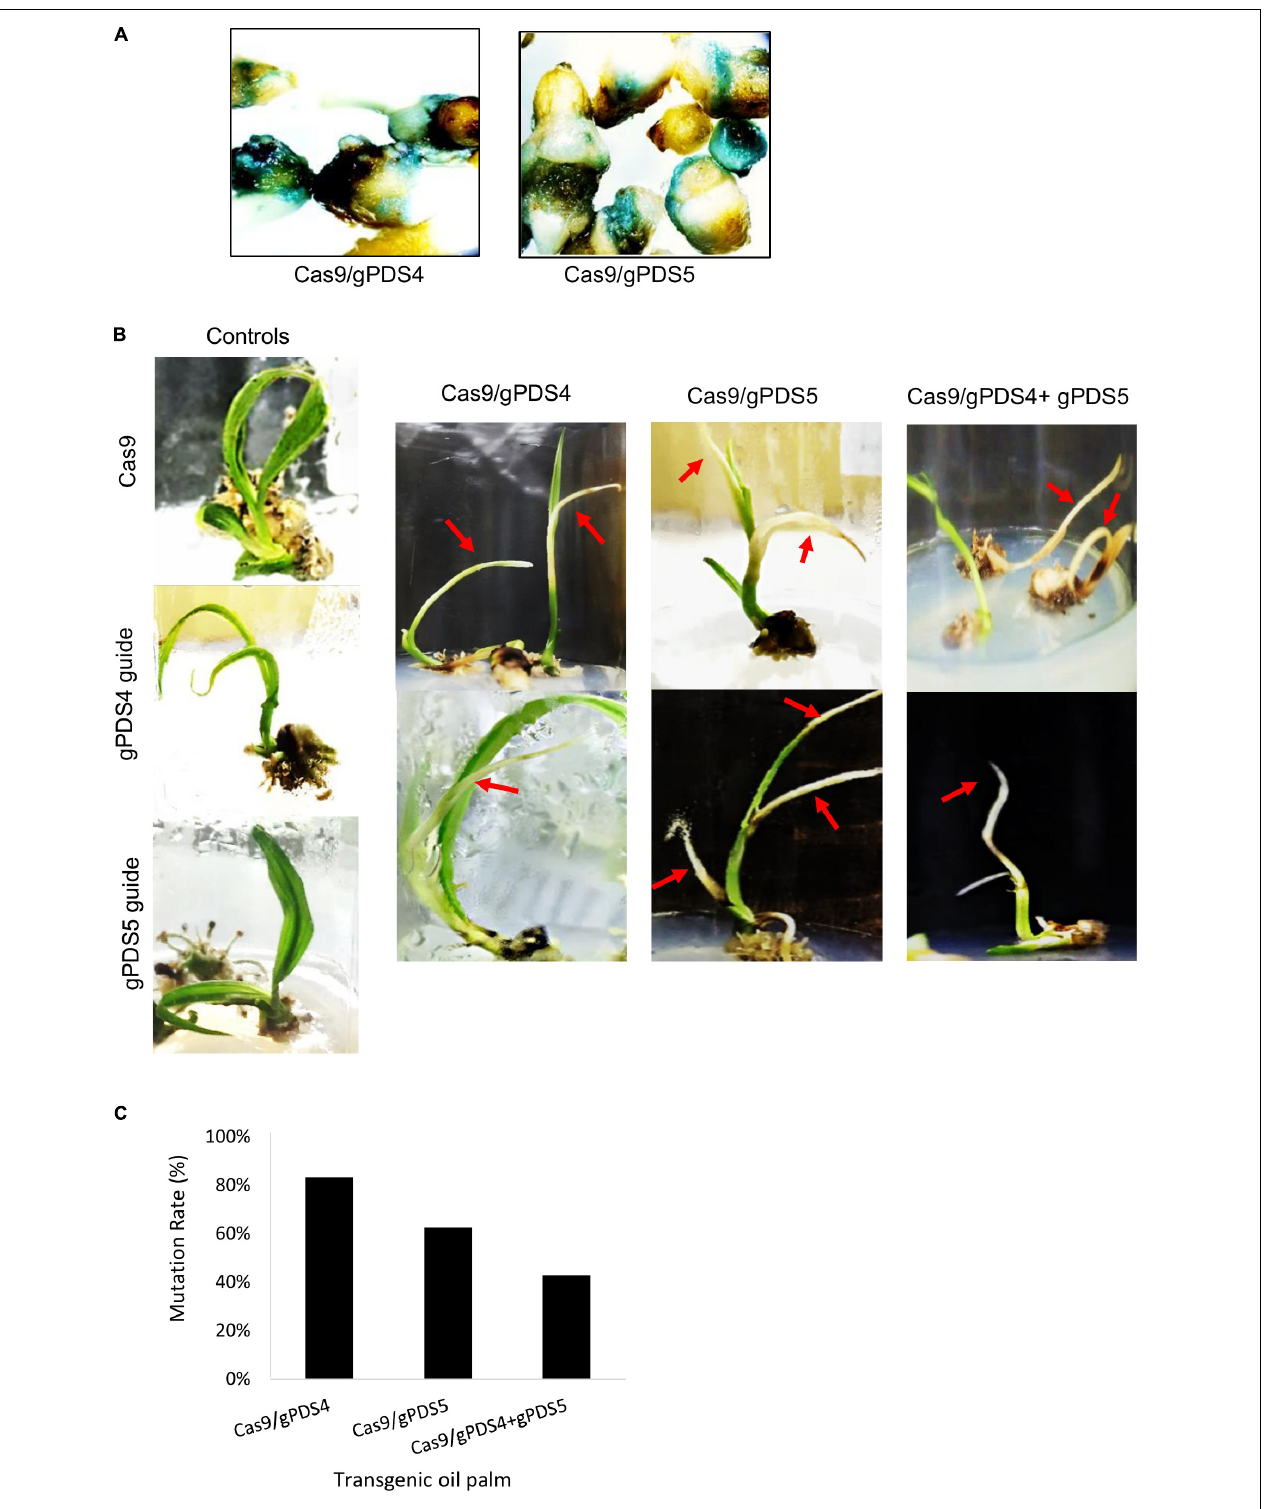
FIGURE 2 | Mutagenesis mediated by CRISPR/Cas9 and gRNA of EgPDS in in vitro transgenic oil palm. (A) Confirmation of genetic transformation by β -glucuronidase (GUS) assay in immature embryos transformed with Cas9/gPDS4 and Cas9/gPDS5. (B) Phenotypes of the Cas9/gPDS4 or gPDS5-mediated mutagenesis and control transgenic in vitro oil palms. Arrow indicating shoots with albino phenotypes. (C) Mutation frequencies of CRISPR/Cas9 mutagenesis in in vitro transgenic oil palms.